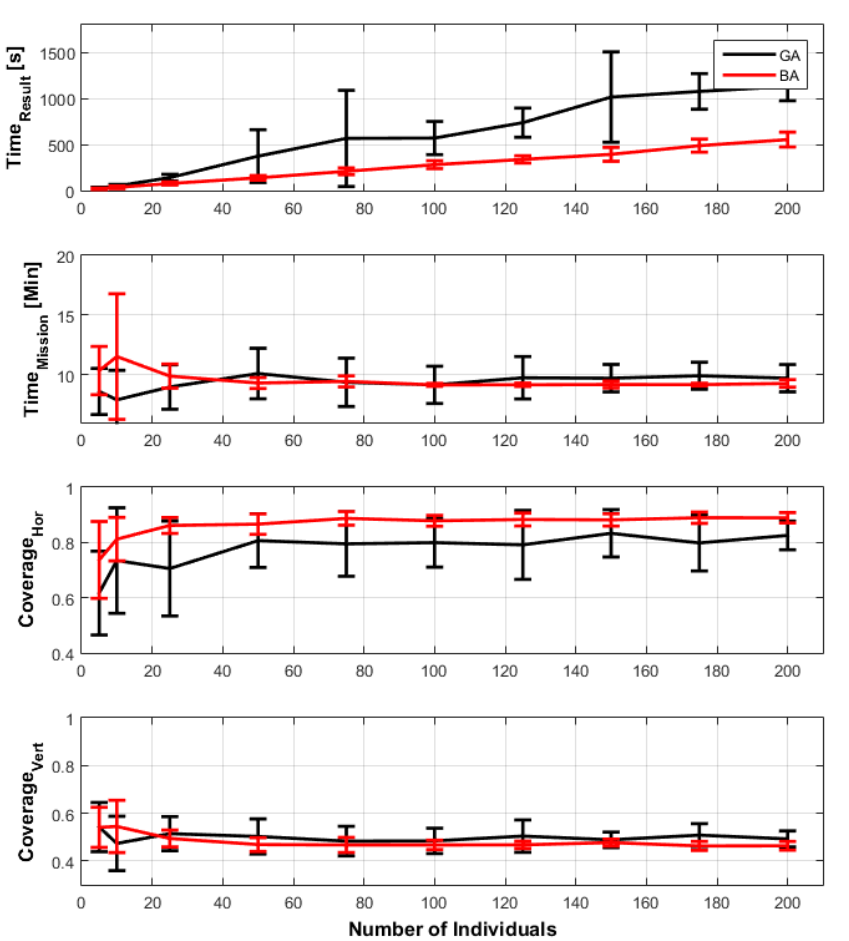
Figure 13. Comparison between GA and BA and its impact comparing numbers of individuals in the population with the time to find the results and objectives of the meta heuristics: time of mission, horizontal, and vertical coverage.